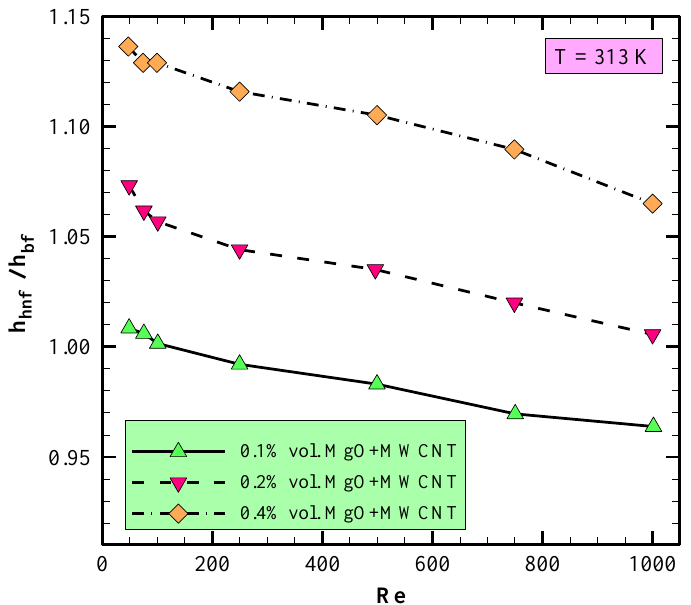
Figure 8. Influence of using HNF with different VF on HT coefficient for various Re and inlet temperature T = 313 K.